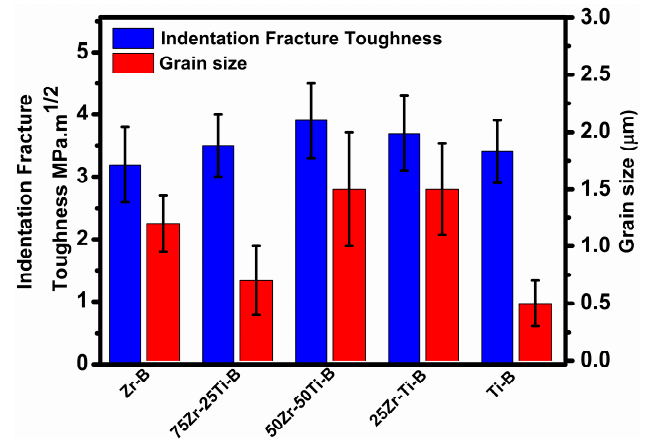
Figure 8. Grain size and indentation fracture toughness of RSPSed samples.